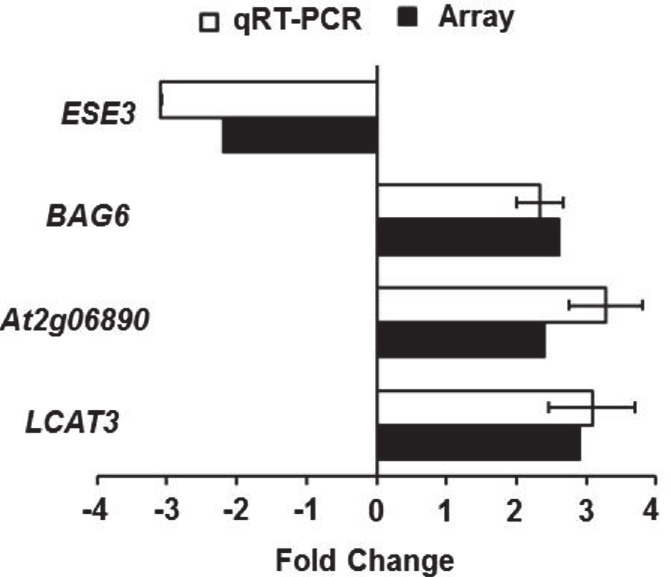
Fig 3. Comparison of values obtained for differential expression using qRT-PCR and microarrays. Relative expression levels obtained through qRT-PCR were compared with microarray expression levels (NASCArrays) for selected common B . cinerea - and abiotic stress-upregulated or-downregulated genes after infection with B . cinerea at 18 hpi. Expression of B . cinerea -induced or-repressed genes was quantitated relative to control conditions (no infection), and corrected for expression of the control β -actin gene. Microarray expression data were obtained from Tables 1 and 2. Error bars for qRT-PCR values are the standard deviations (n (cid:2) 3). hpi, hours post inoculation; At Actin2 , Arabidopsis Actin2